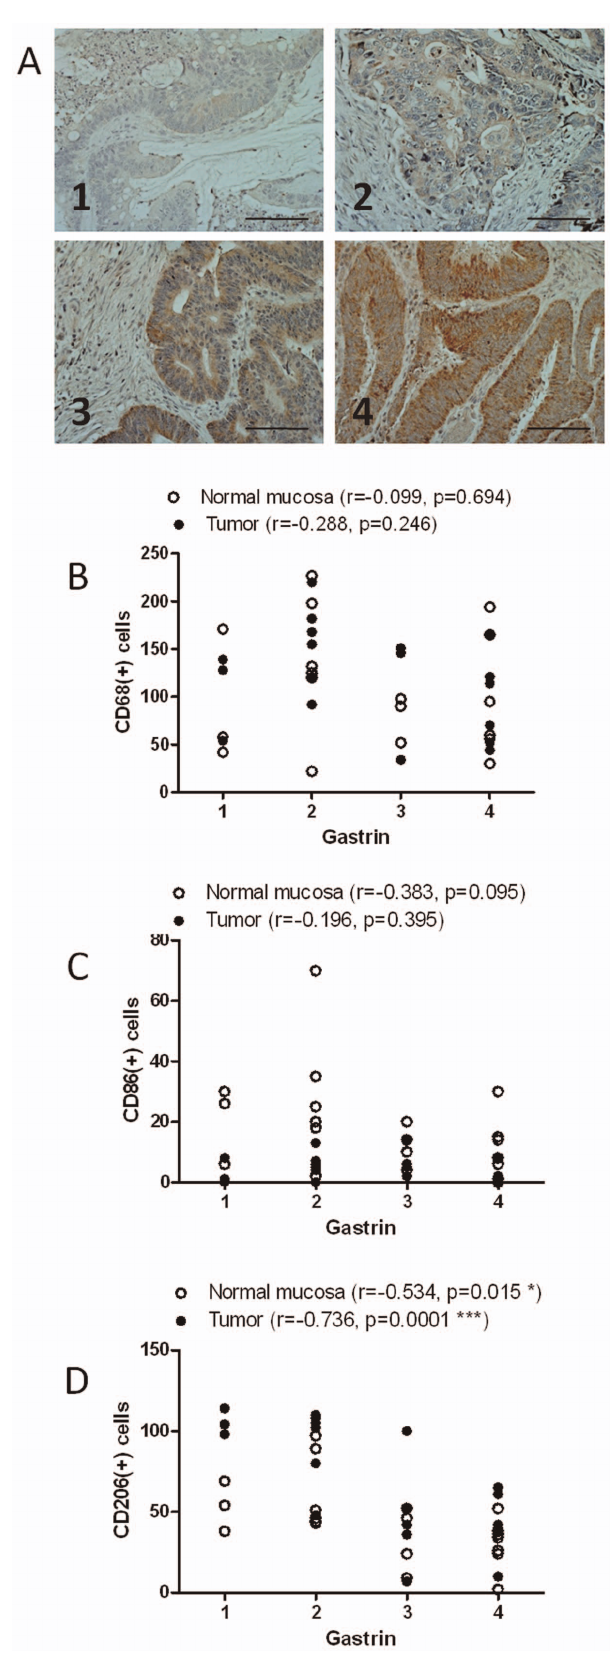
Figure 2. Relationship between gastrin expression and the pattern of macrophage infiltration in colorectal cancer sam- ples. The number of total macrophages (CD68 + cells, B), M1- macrophages (CD86 + cells, C), and M2-macrophages (CD206 cells, D), in the tumor and normal surrounding tissue were analyzed in relation to gastrin expression in tumoral tissue (A, score 1 to 4, scale bar =0.2 mm). A negative and significant correlation is observed between the intensity of gastrin staining and the number of M2-macrophages in normal mucosa and tumoral tissue